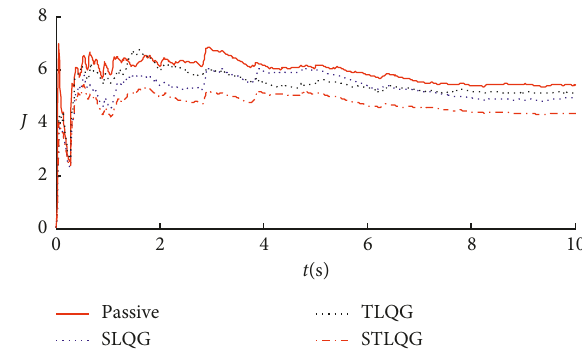
Figure 12: J - t curves under 30ms time delay.